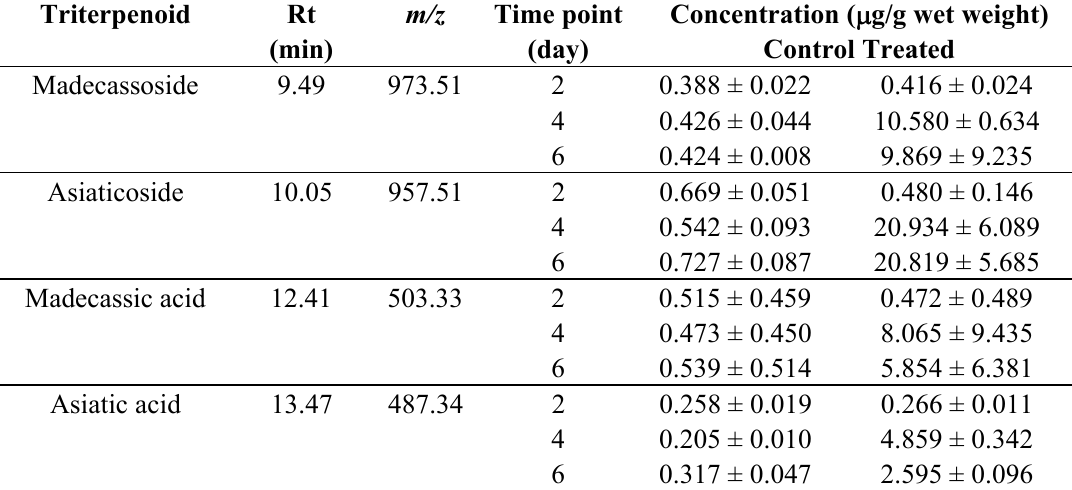
Table 2. Quantification of the targeted pentacyclic triterpenoids (centellosides) in 0.2 mM MeJa-treated cell suspensions of C.